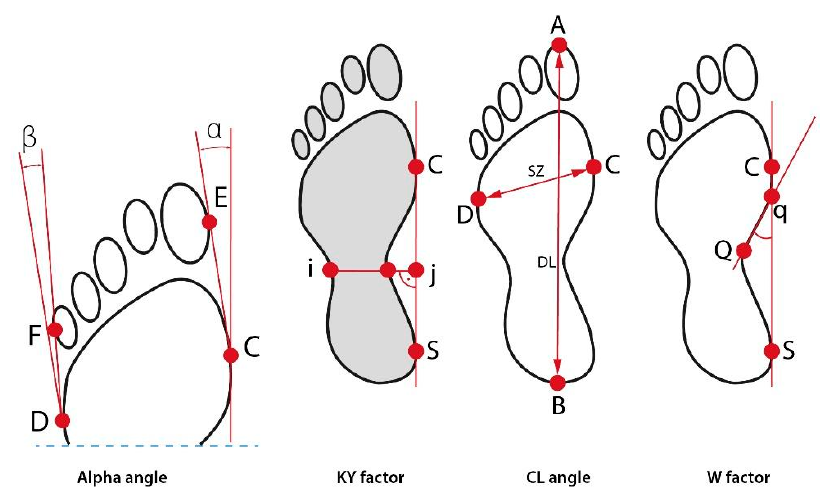
Figure 1. Parameters determining foot deformities. α -hallux valgus angle; β -little toe angle, A-front edge of the foot; B-rear edge of the foot; C-medial edge of the foot; D-lateral edge of the foot; E-outside edge of the hallux; F-outside edge of the little toe, i-lateral edge of plantar contourograph, j-medial edge of plantar contourograph; S- medial edge of the hindfoot; Q, q-internal points of the foot, DL-foot length; SZ-foot width.